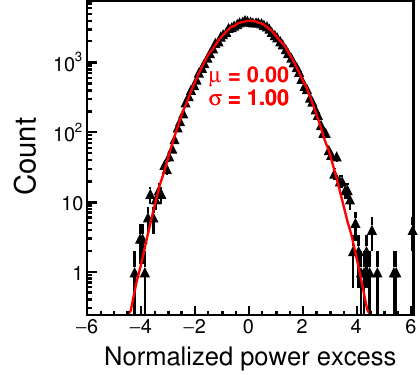
Figure 6 . The figure shows the same data as in the bottom left of figure 4 but with the correlation matrices fully